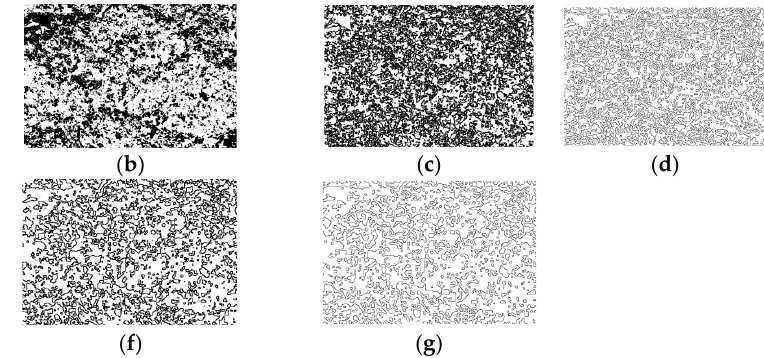
( g ) Figure 6. ( a ) SEM image of A2Y5 processed at 1815 °C at scale: 10 μ m; ( b ) image converted to bi- nary; ( c ) detected edges (Find Edges tool) giving an FD = 1.729; ( d ) detected edges (CED plugin) giving an FD = 1.318; ( e ) image converted to binary with the median filter applied, ( f ) detected edges median filter applied, FE tool, FD = 1.405; ( g ) detected edges, median filter applied, CED plugin, FD = 1.269 (image looks fainter than ( d ) image). Results from processing all 206 micrographs with the two edge detection techniques were analyzed. Figure 7a – d shows the histograms of (a) A, (b) rho, (c) FD obtained by using the Find Edges tool, and (d) the Canny Edge Detector plugin. Absorption and Density were characterized by using the 42 cases data in Table 2, and fractal dimension was characterized by using the 206 cases corresponding to the 206 images available, processed successively with the Find Edges tool and Canny Edge Detector plugin. An abnormality was recorded for Absorption less than 5% (15 cases of 42); these cases were processed at high temperatures (1815 °C), were made from A3 alumina, and/or contained Y and Nd oxides in the highest concentrations. The same histogram also displays two cases isolated from the rest of the observations, belonging to plasma-processed speci- mens that have very high absorptions, around 38%. The fractal dimension obtained using the Find Edges tool has a significant departure from normality in the 1.9 – 2 bin due to the high noise and thick edges that resulted from using that tool. Density and Fractal di- mension obtained by using Canny Edge Detector plugin showed almost normal distri- butions. Adding to the previous partial conclusions deduced by comparing the effec- tiveness of the two techniques, the Canny Edge Detection plugin gives more accurate